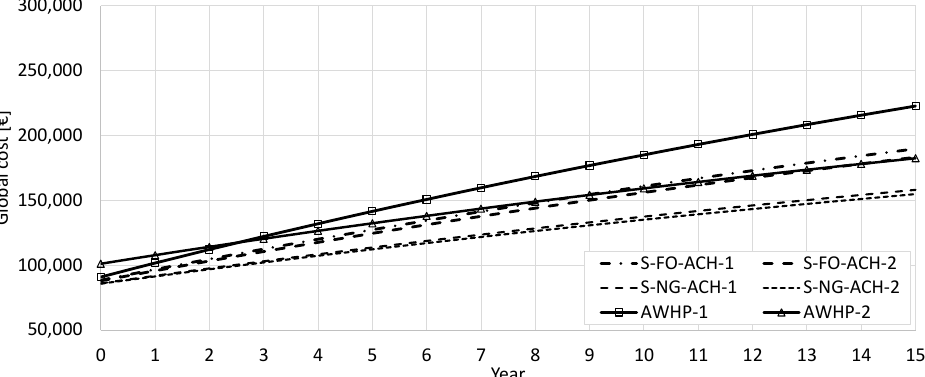
Figure 15. Lifetime costs for energy price scenario S1 and reduced investment cost for absorption SHC systems.